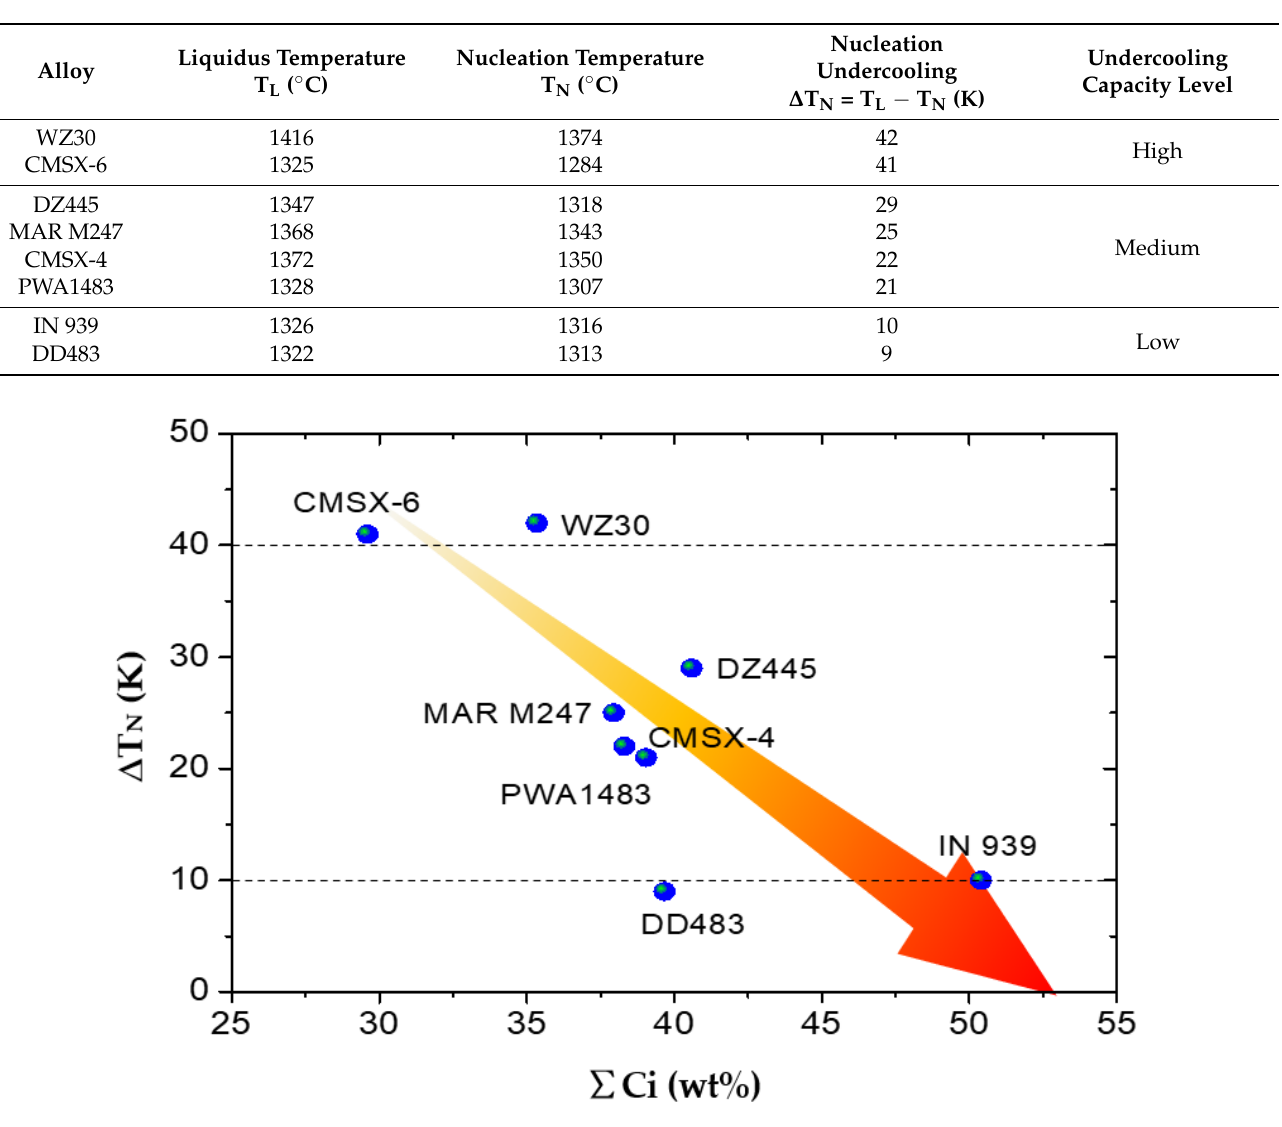
Figure 6. Influence of the total percentage of the added alloying elements ( ∑ Ci) on the undercooling capacity ( ∆ T N ) of the studied superalloys.